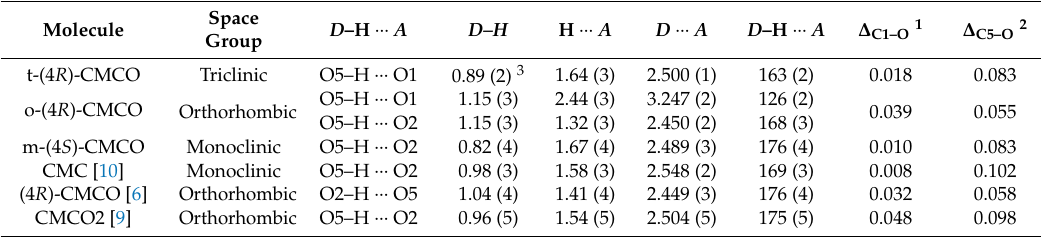
Table 1. Comparative geometries (Å, °) of carboxylate-carboxylate hydrogen bonds in CMCO and related structures.